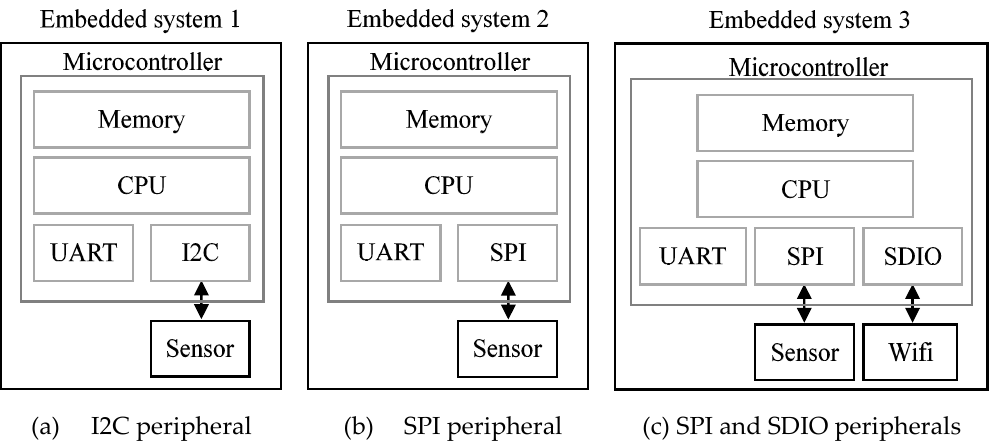
Figure 1. Diverse peripherals for embedded systems. Note: I2C, interintegrated circuit; SPI, serial peripheral interface; SDIO, secure digital-input/-output interface.